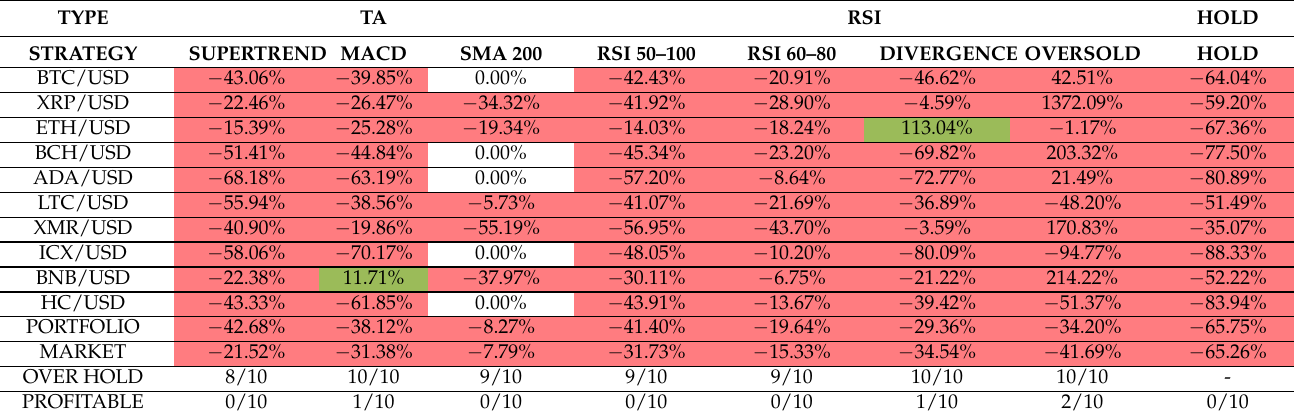
Table 10. The results of strategies from experiments compared to popular trading strategies and strategy proposed by authors between 2022 and 2023. Green indicates positive results, red indicates negative